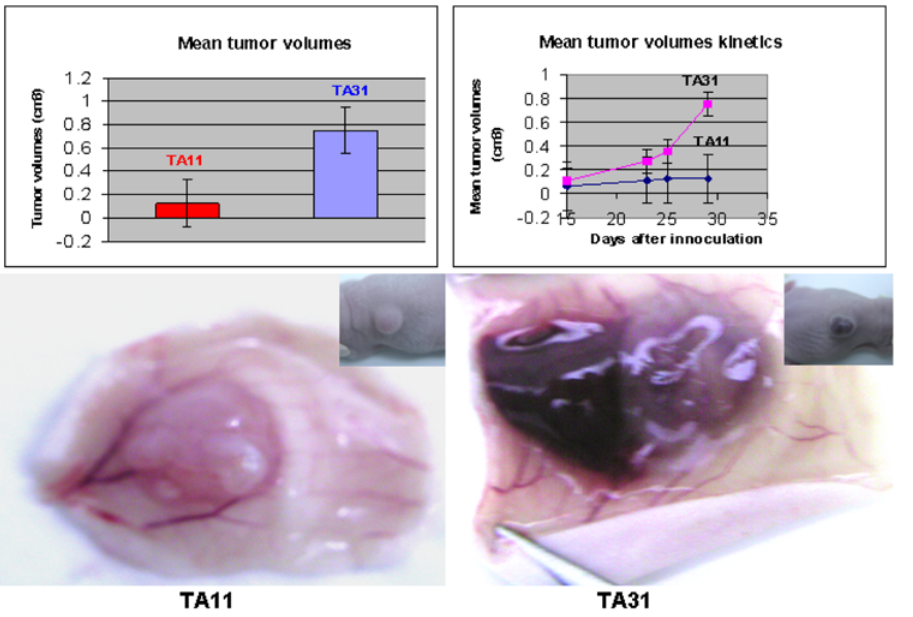
Figure 5. The effect of over-expression of H19 RNA on the tumorigenic potential of bladder carcinoma cells in vivo. Equal amounts (2 6 10 6 ) of TA31 H19high and TA11 H19-ve cells were implanted subcutaneously to CD-1 mice (n=5, each). Two weeks later, palpable tumors appeared and tumor volumes were measured for an additional two weeks . Shown are end point measurements of the mean tumor volumes of the two groups (upper left pannel), their mean tumor volumes kinetics (upper right), and a representative gross morphology of tumors derived from the TA11 H19-ve (lower left) and TA31 H19high cells(down and right).